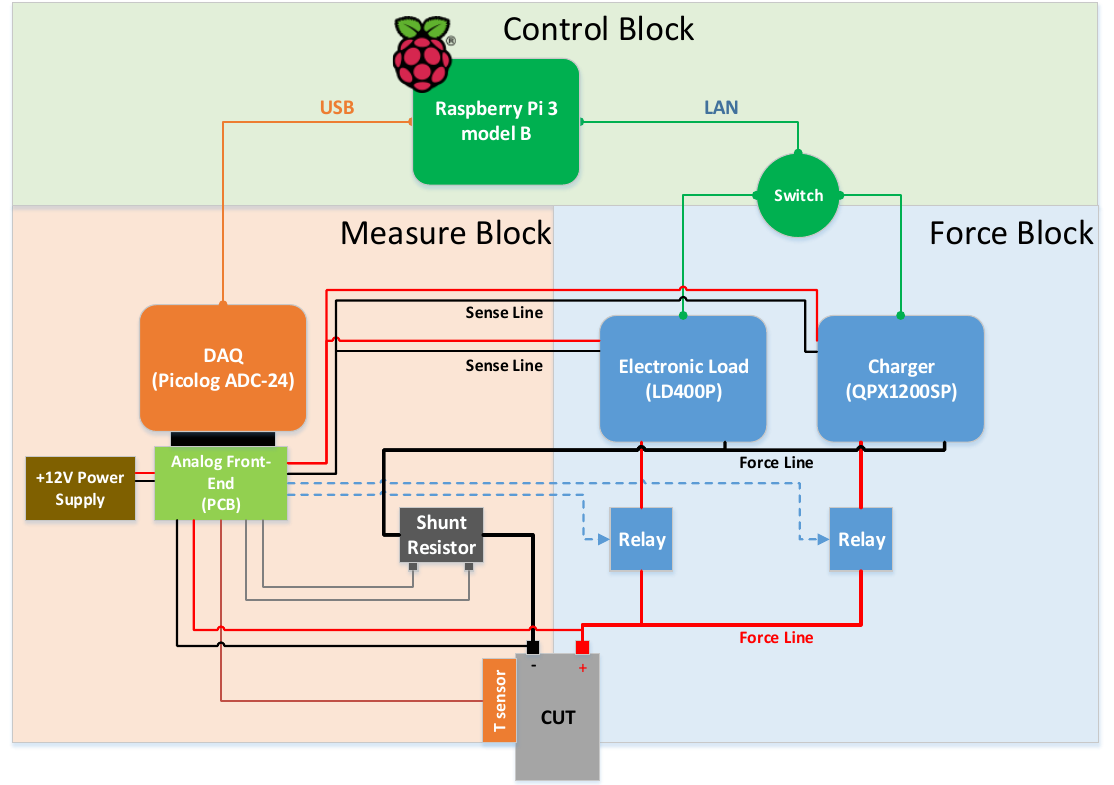
Figure 1. Hardware framework of the Cell Station Tester.